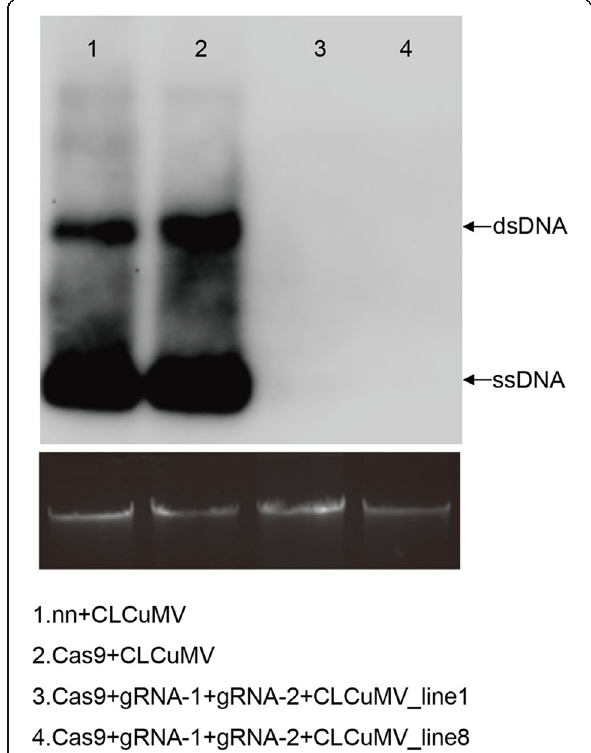
Fig. 5 Testing of CLCuMuV genomic DNA accumulation. Southern blot analysis of CLCuMuV genomic DNA accumulation in control and transgenic plants 35 dpi with CLCuMuV. CLCuMuV genomic DNA was detected with DIG-labeled random primed probes against the sequence of CLCuMuV. 1 to 4 represent WT, Cas9 transgenic, Cas9 + gRNA-1 + gRNA-2 transgenic line1, and Cas9 + gRNA-1 + gRNA-2 transgenic line8,